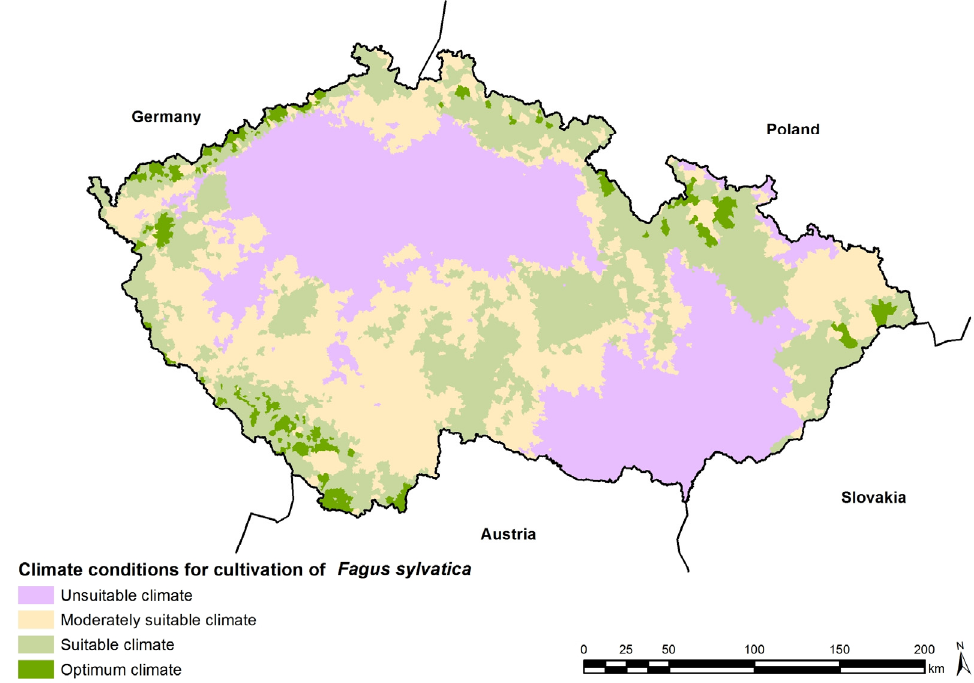
Figure 6. Visualization of predicted distribution of climate conditions for the European beech in the Czech Republic in 2090.